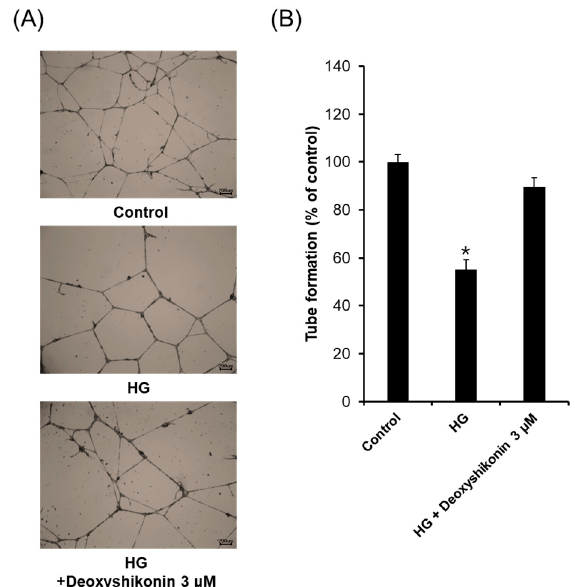
Figure 7. Tube formation effect of deoxyshikonin when HUVEC was exposed to HG. ( A ) Photographs of capillary-like tube formation in HUVECs exposed to high glucose (HG) on Matrigel after incubation with 3 µM deoxyshikonin after 24 h. ( B ) The relative lengths of tubes were measured using the ImageJ software. Data are expressed as means ± SEM. Similar results were obtained from three independent experiments; * p < 0.05 compared to the control value.